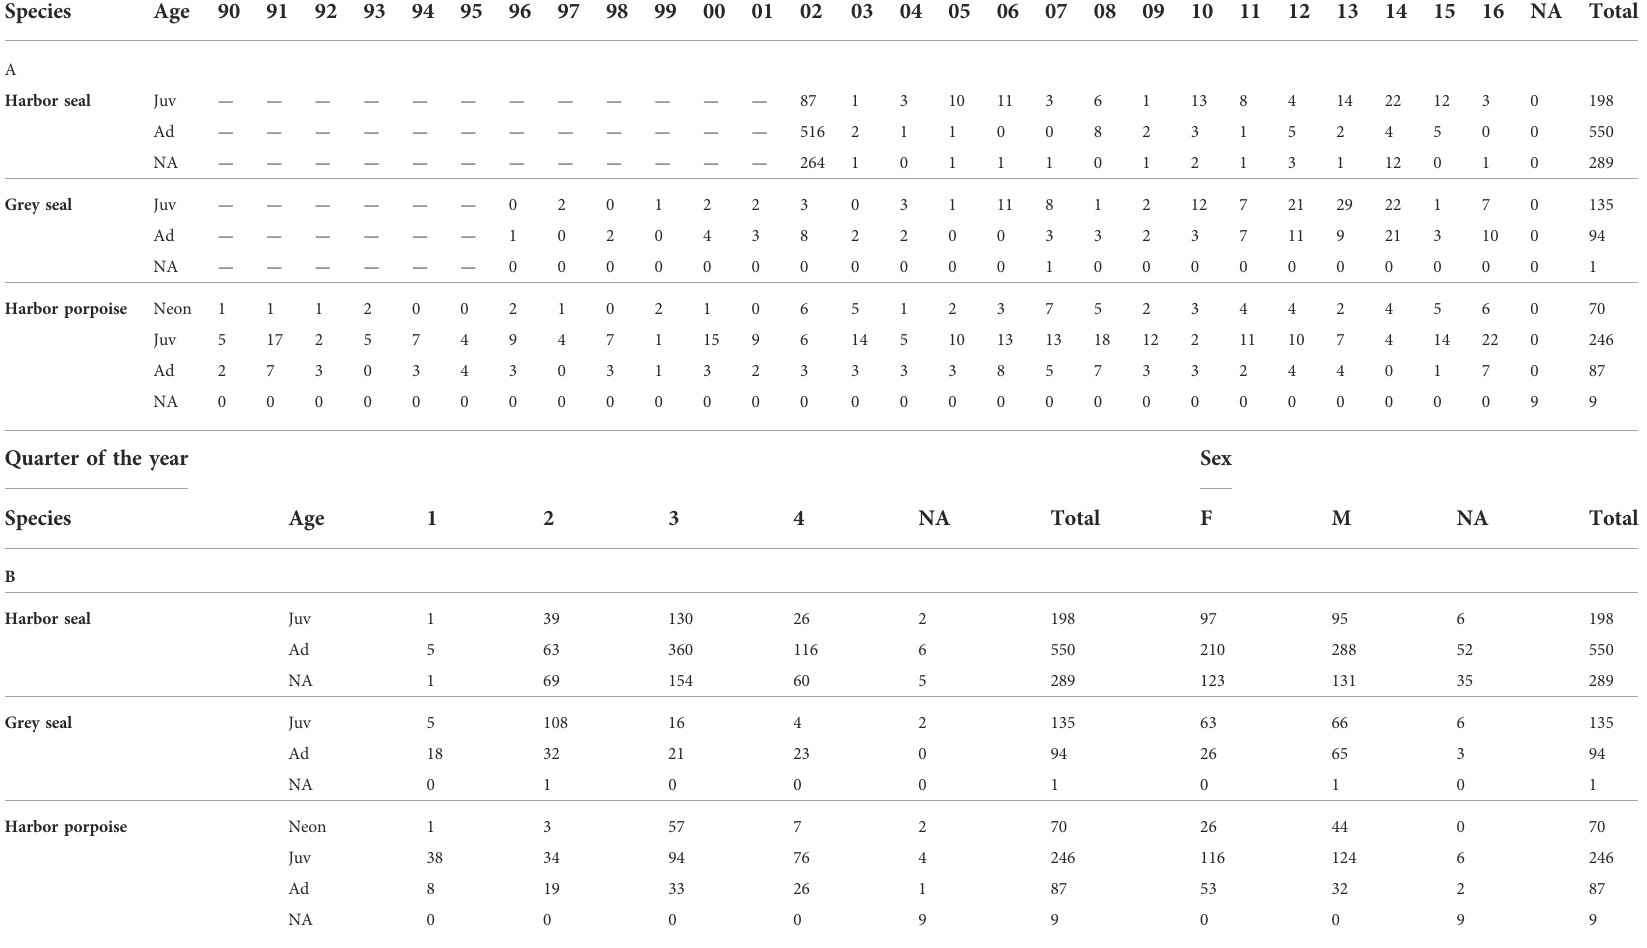
TABLE 2 Overview of samples included in the analysis (harbor seals: n = 1,307; Denmark — 925, Germany — 111, Unknown location — 1; grey seals: n = 230; Germany — 113, Poland — 88, Denmark -28, Unknown location — 1; harbor porpoises: n = 412; Germany — 334, Denmark — 55, Poland — 13, Unknown location — 10). A) Distribution of individuals over the collection period (harbor seals — 2002 – 2016, grey seals — 1996 – 2016, harbor porpoises — 1990 – 2016). Juv, juvenile, Ad, adult, NA, Not attributed, Neon, neonate. B) Distribution of individuals over each quarter of the year, by sex and by age group. 1 — January – March, 2 — April-June, 3 — July-September, 4 — October-December. F — female, M — male, NA, Not attributed. Juv, juvenile, Ad, adult, NA, Not attributed, Neon. — neonate. Species Age A Harbor seal — — — — Grey seal